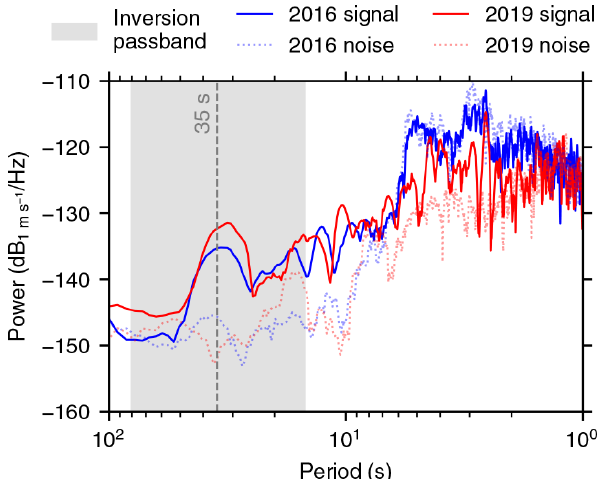
Figure 5. Power spectral densities (PSDs) of vertical-component seismic signals from the 2016 (blue lines) and 2019 (red lines) avalanches. The signals were recorded at Alaska Earthquake Cen- ter station HOM, the closest station to Iliamna Volcano used in both force inversions. Dotted lines are the PSDs for a 1000s post- avalanche time window and indicate the approximate contempora- neous noise level. The gray box indicates the force inversion pass- band